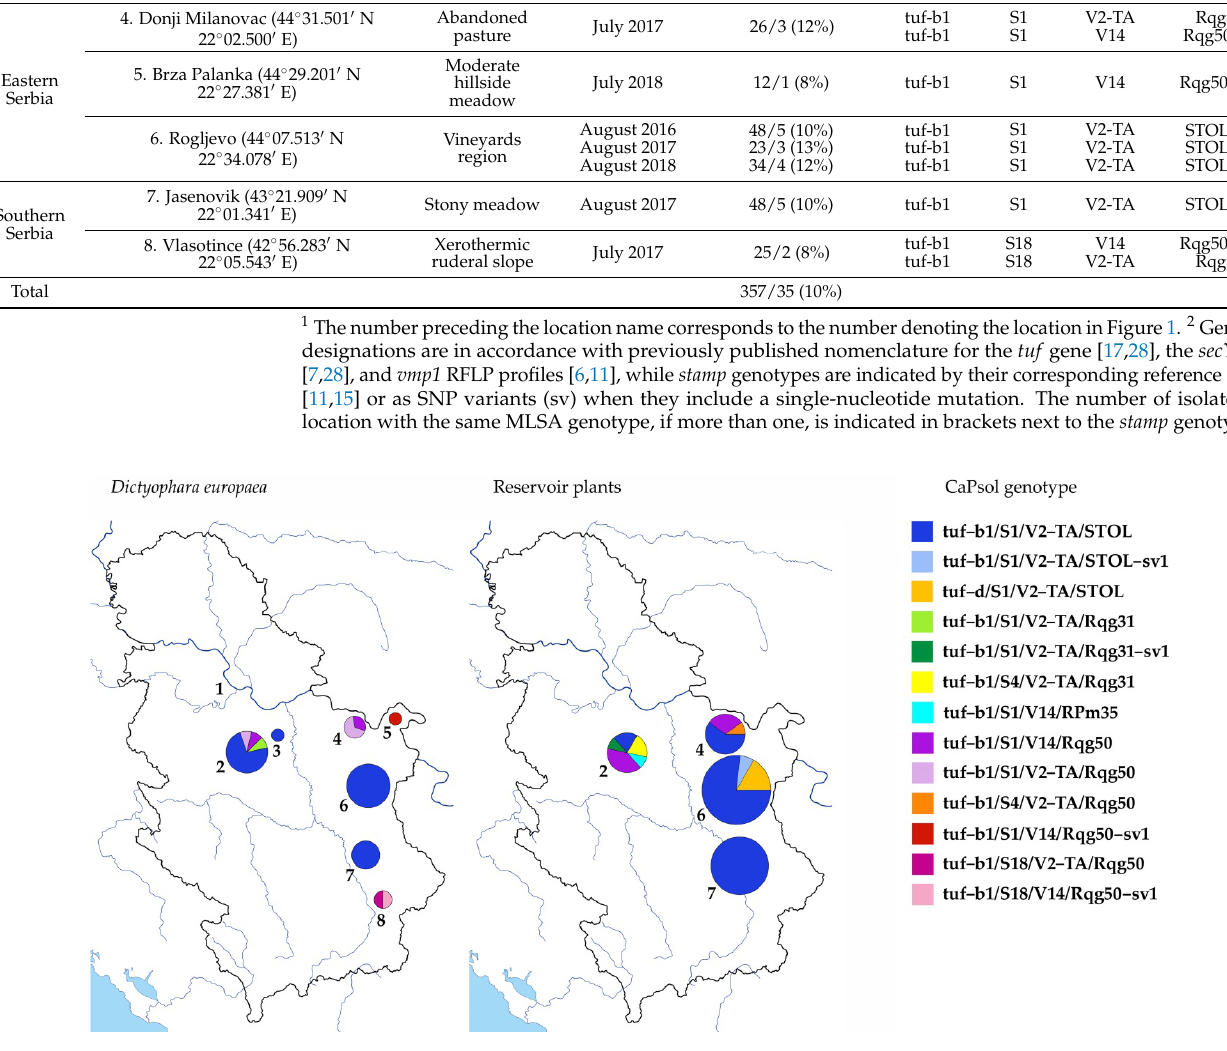
Figure 1. Map of surveyed localities in Serbia for occurrence of fulgoroid planthopper Dictyophara europaea and its tentative host plants naturally harboring ‘ Candidatus Phytoplasma solani’. For each location diversity and frequencies of ‘ Candidatus Phytoplasma solani’, multilocus genotypes based on tuf , secY , vmp1 , and stamp genes are presented for Dictyophara europaea populations and tentative reservoir plants. Pie chart sections represent the proportion of specific multilocus genotypes. Maps were generated with d-maps.com (https://d-maps.com/carte.php?num_car=27550&lang=en, accessed on 29 May 2022).